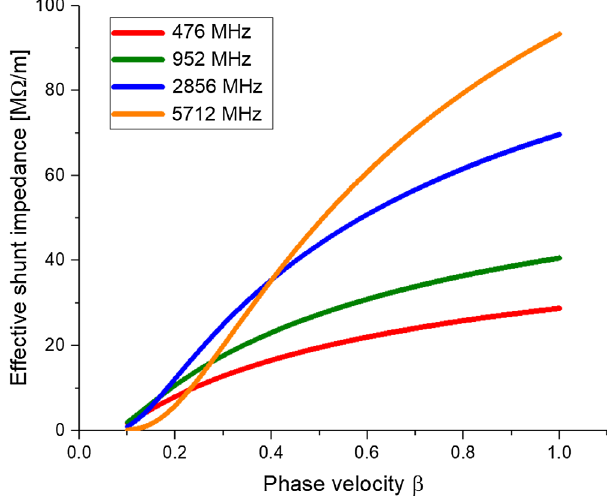
FIG. 5. Phase slippage of the beam center in a 28.5 cm long β ¼ 0 . 3 section. The dots represent different